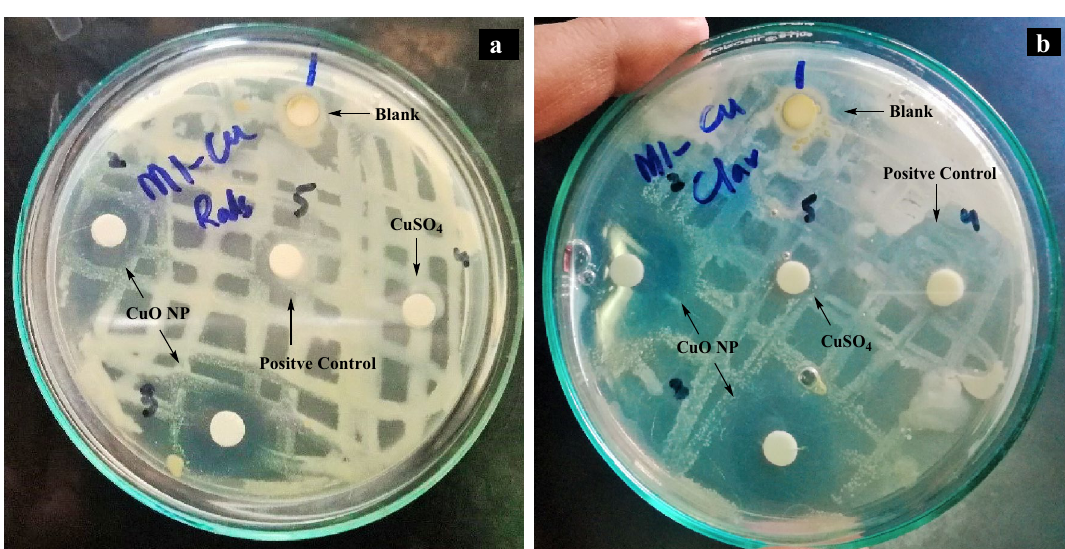
Figure 6. Zone of inhibition of ( a ) Ralstonia solanacearum and ( b ) Clavibacter michiganensis .